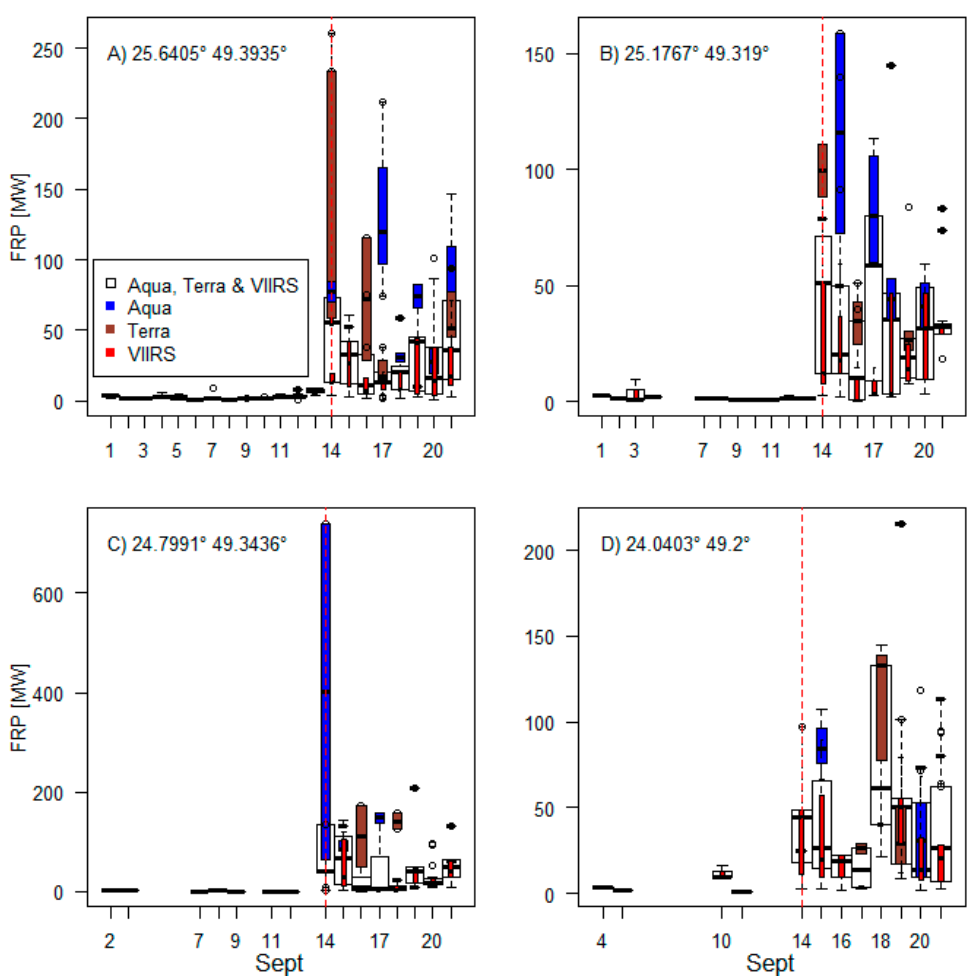
Figure 3. Time series of 4 µ m fire radiative power (FRP) retrieval from three satellites is summarized as whisker plots for the four ( A – D ) flares illustrated in each frame of Figure 1. Central geographic coordinates are shown for each flare site illustrated in Figure 1 is also shown in each frame. The mean is boxed by the 75th and 25th percentiles. MODIS Terra and Aqua are identified as brown and blue box and whisker plots, respectively, and VIIRS is shown as red. Open box summaries include all observations from all three satellites. The vertical dashed red line marks the day of emergency flaring. Different satellites with different overpass times have different FRP retrievals after the day of flaring and highlights the ephemeral and changing conditions at the flare site.